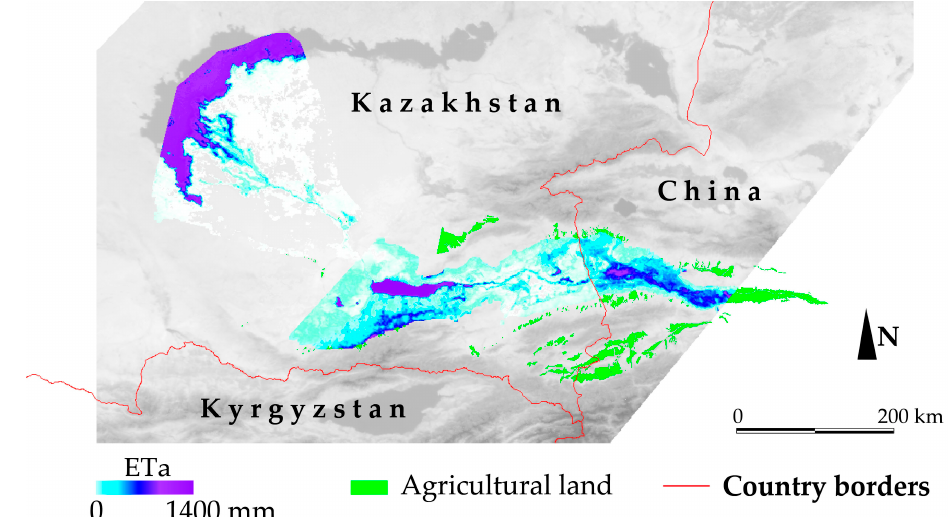
Figure 3. Map of actual evapotranspiration (ET a ) in 2014. In this map, ET a of open waters has not been corrected to 1000 mm during the growing season. The greyish background is the land surface temperature (LST) image from 5 August 2014 of the Moderate Resolution Imaging Spectroradiometer (MODIS) scene path 23 row 4.